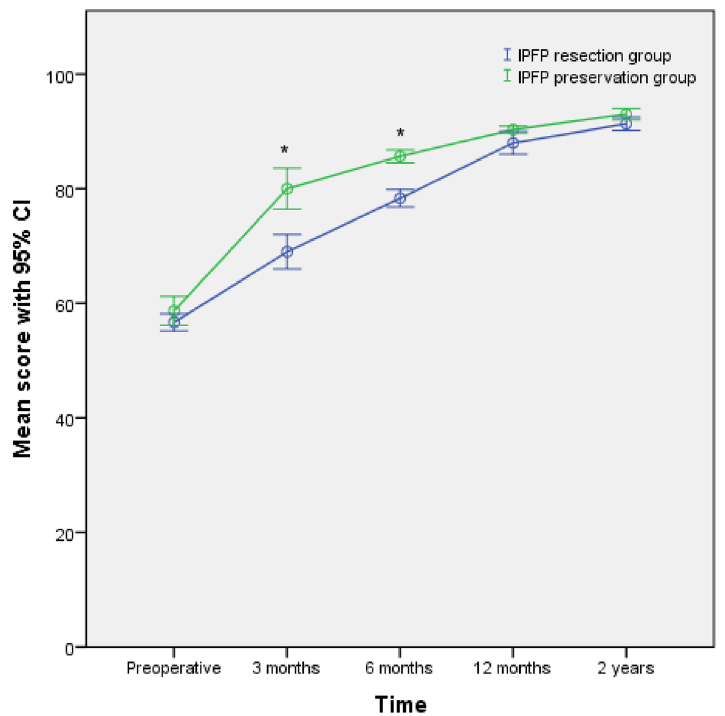
Figure 4. The mean overall KOOS for both groups at different intervals with a 95% confidence interval (CI). *P < 0.05 between the 2 group scores at 3 months and 6 months postoperatively ( IPFP infrapatellar fat pad).